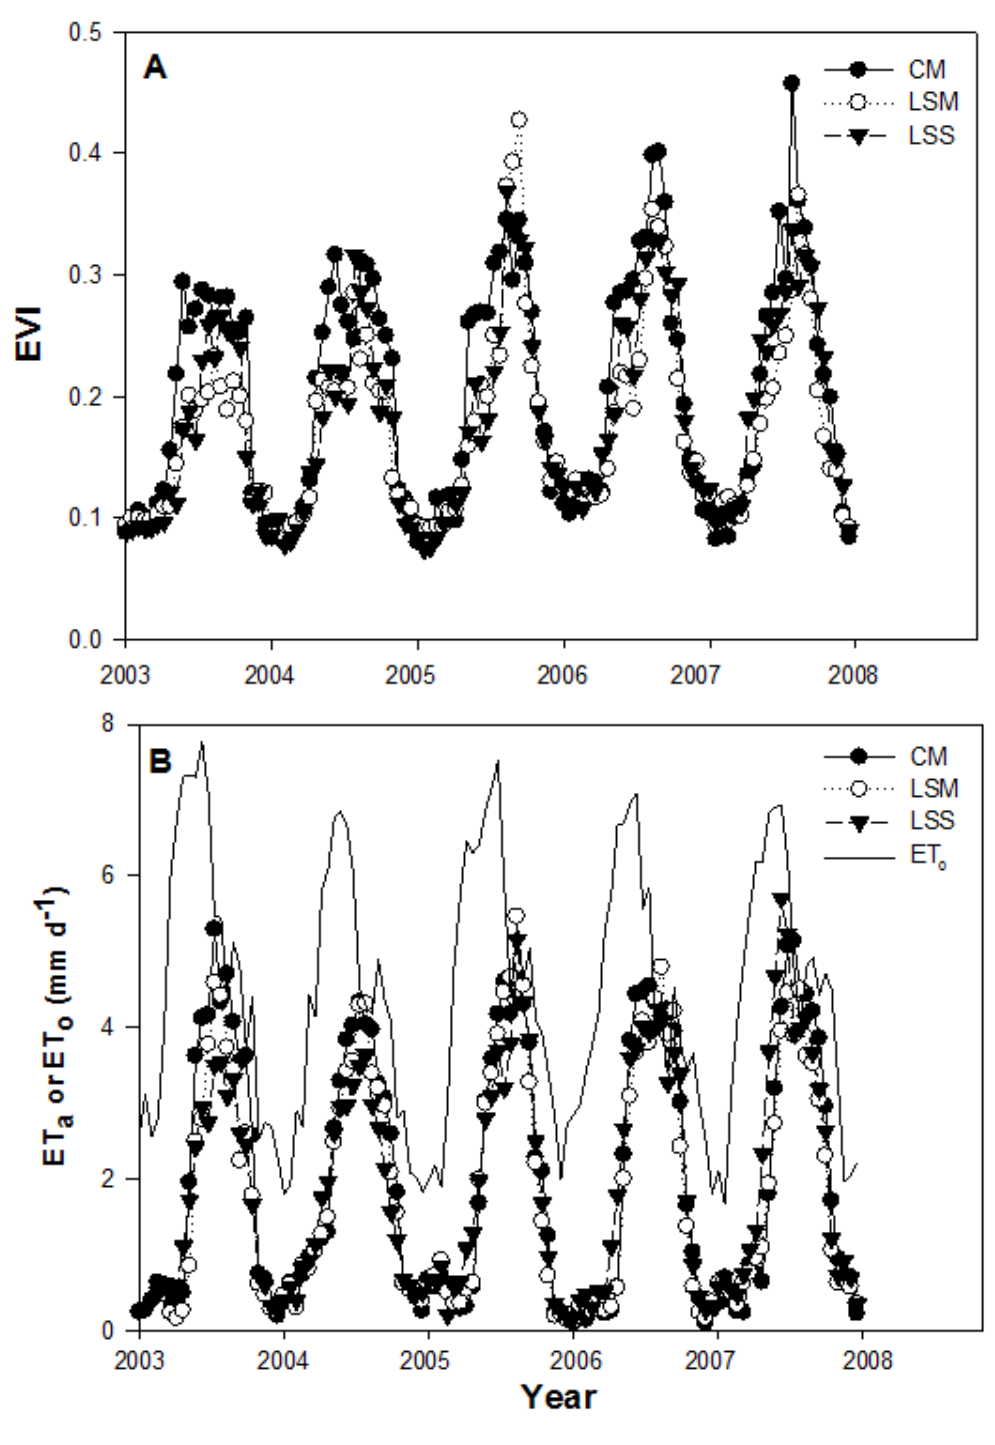
Figure 2. ( A ) EVI values for pixels corresponding to moisture flux towers on the San Pedro River used for model calibration; ( B ) ET ET . CM = Charleston mesquite site; LSM = Lewis Spring mesquite site; LSS = Lewis o Spring sacaton grass